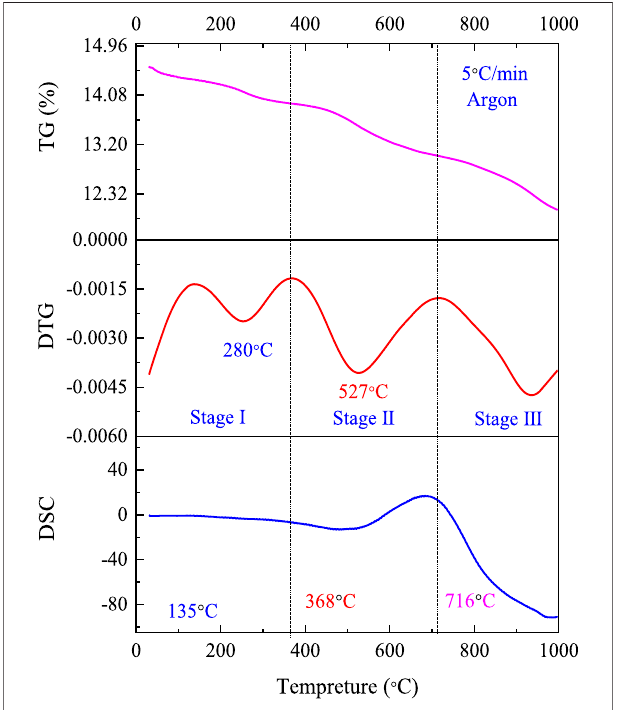
FIGURE3| TG-DTG-DSCcurvesoflow-gradepyrolusitewith10%coal.